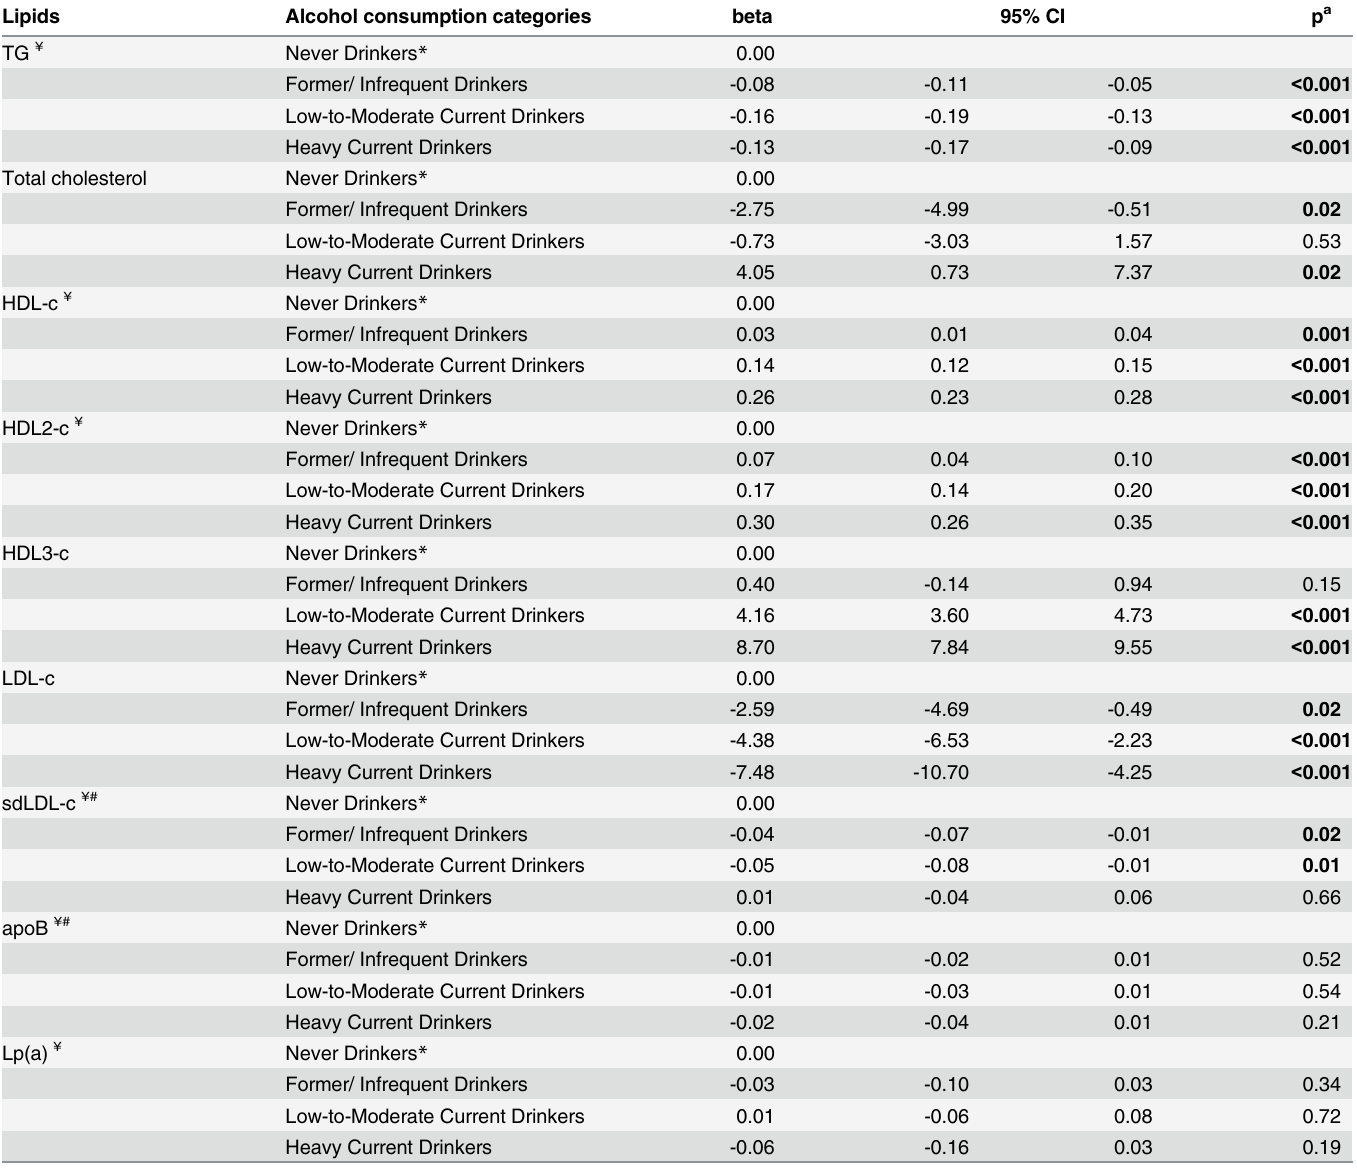
Table 2. Association between observed alcohol consumption category and lipids.